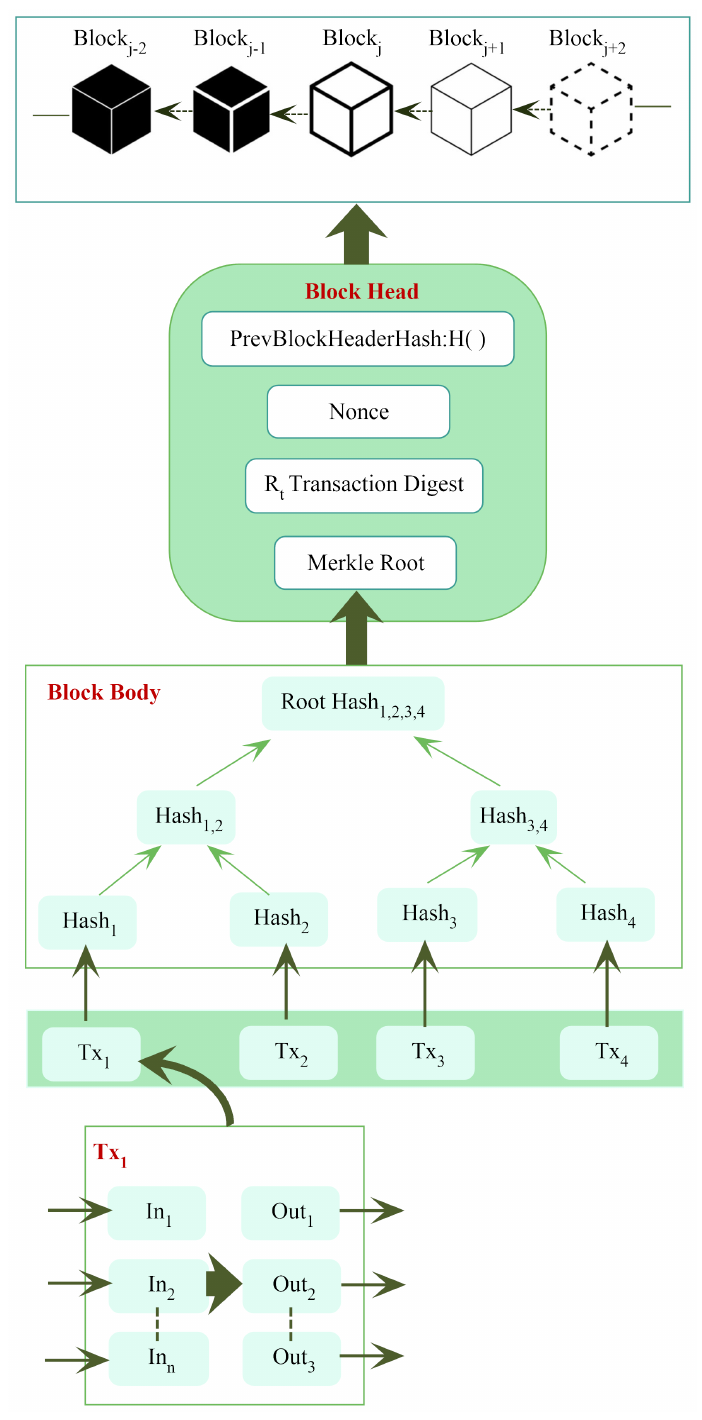
Figure 1. Proof of Work (PoW)